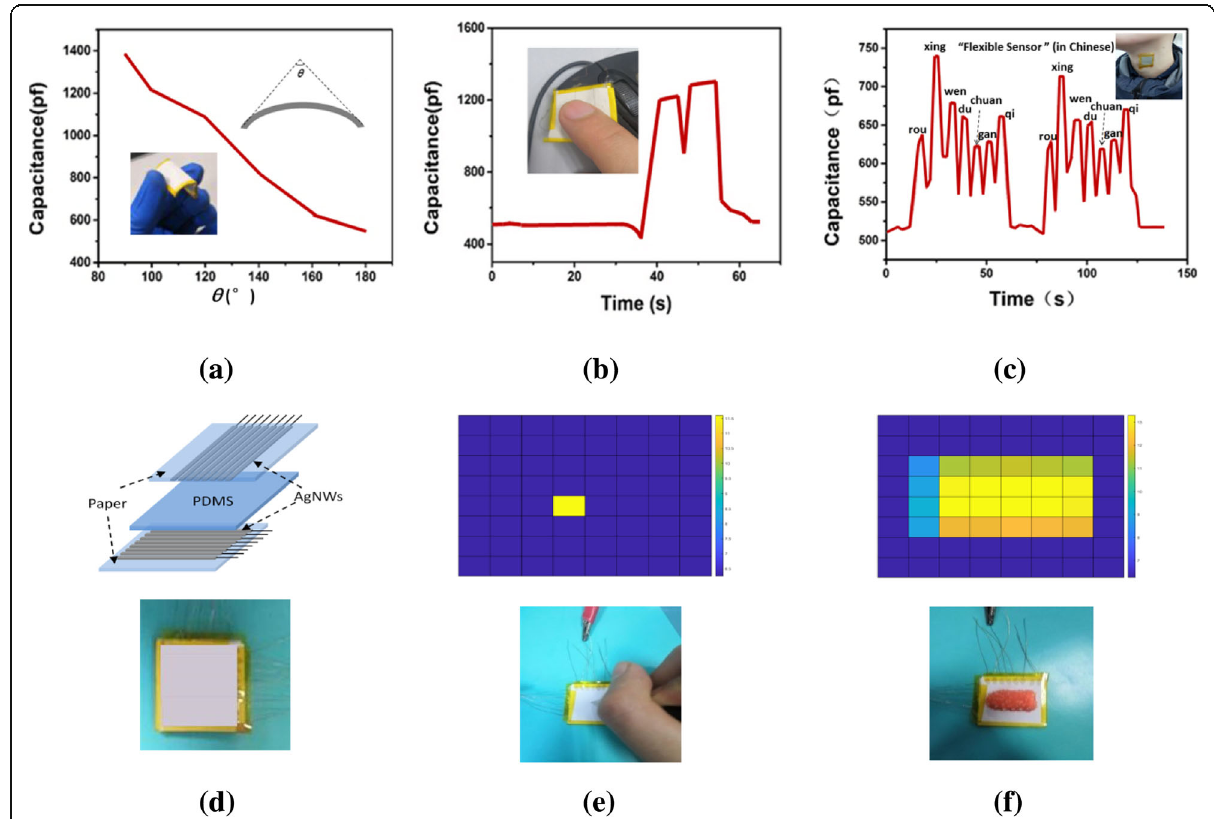
Fig. 5 Applications of AgNW-paper-based capacitive FPS: a bending test, b finger tap test, c voice test, d 8 × 8 array of AgNW-paper-based capacitive FPS, e detection of a pencil tip, f detection of a bullet shape handmade from